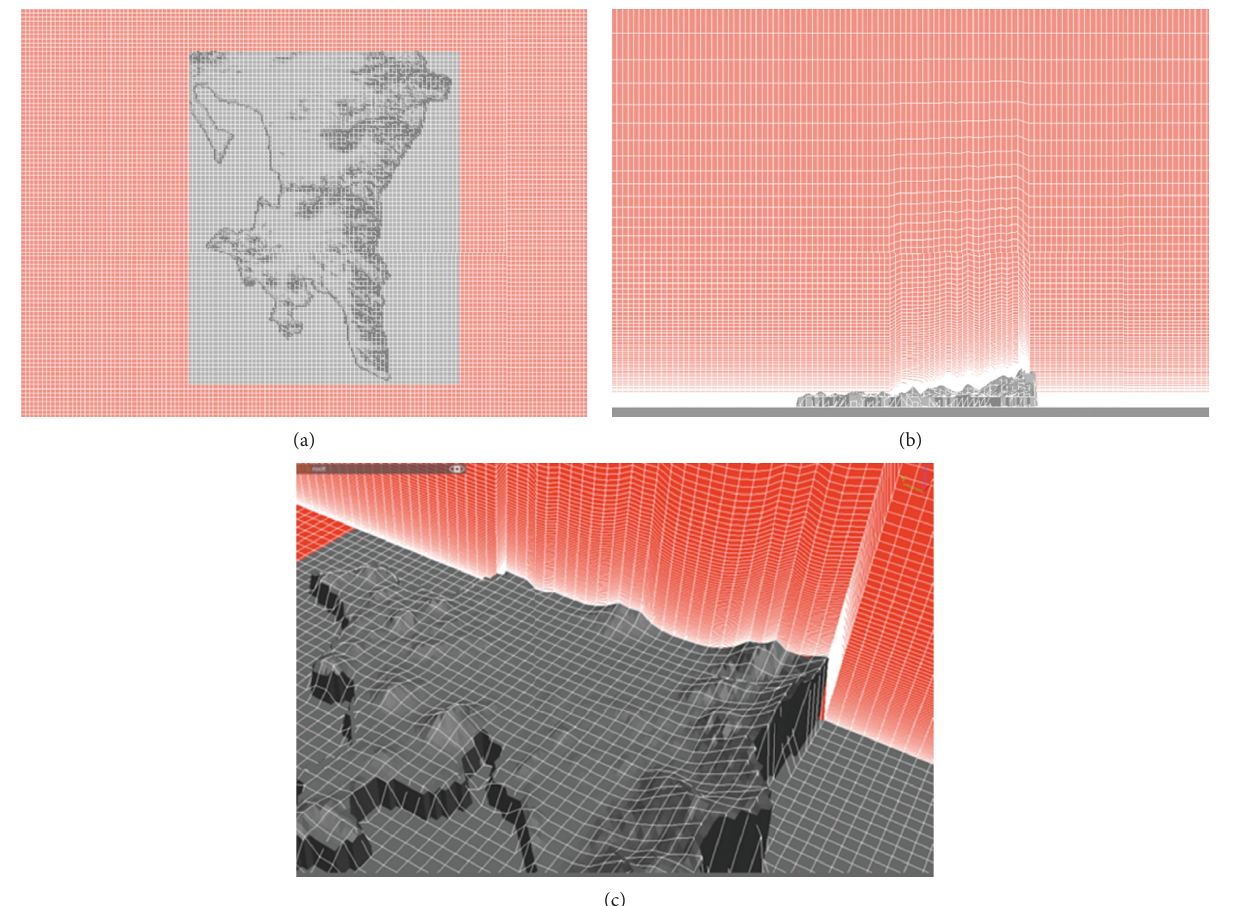
Figure 5: Meshing process in FXgen . The GUI application allows the desired parameters to be explored with confirmation of the mesh distribution. (a) Uniform mesh in the XY direction. (b) Stretched mesh in the Z direction. (c) Closeup view near the surface.